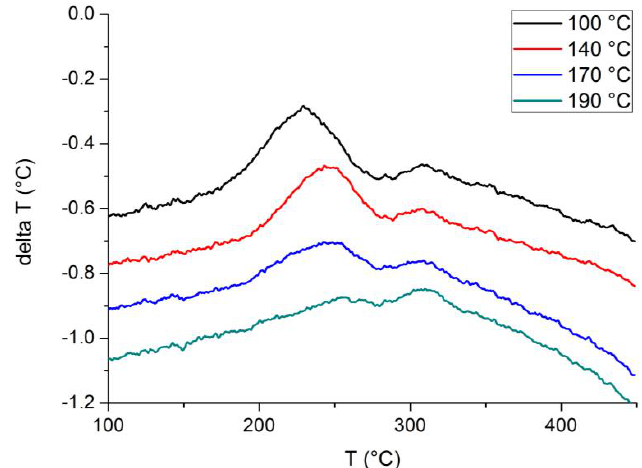
Figure 4. Differential thermal analysis (DTA) measurements of A357 samples produced with different building platform temperatures.